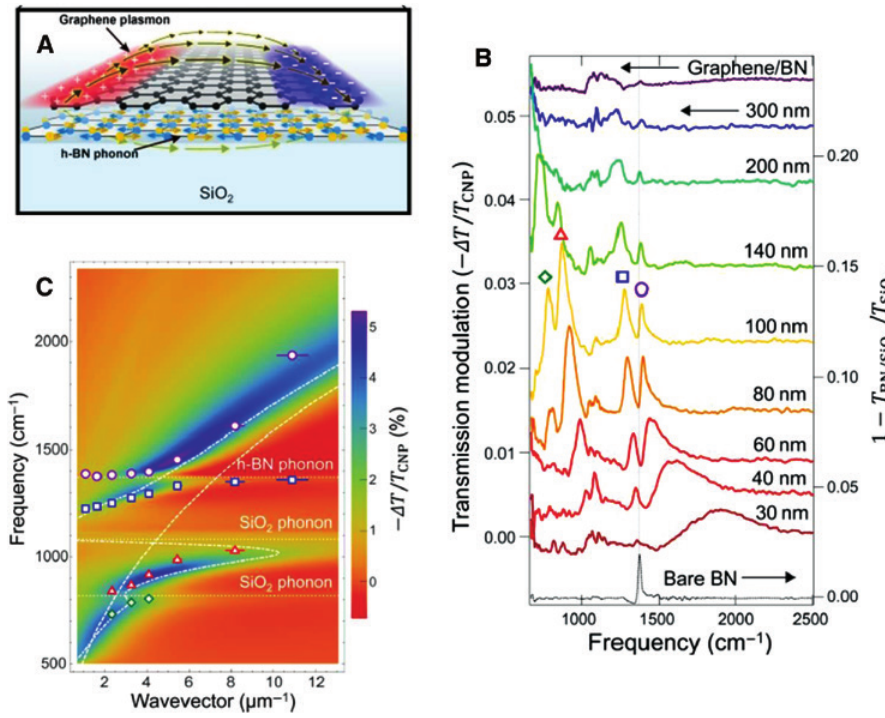
Figure 6: Plasmon-phonon coupling for graphene plasmons. (A) Sketch for graphene plasmon and h-BN polar phonons. (B) Extinction spectra of graphene nanoribbons with different ribbon widths on single-layer h-BN, sitting on the SiO /Si substrate. A bare h-BN spectrum is also shown. (C) Calculated loss function map using the RPA 2 method. Extracted plasmon frequencies are also shown as discrete points. (A–C) Reproduced with permission from [26]. © Copyright 2014 American Chemical